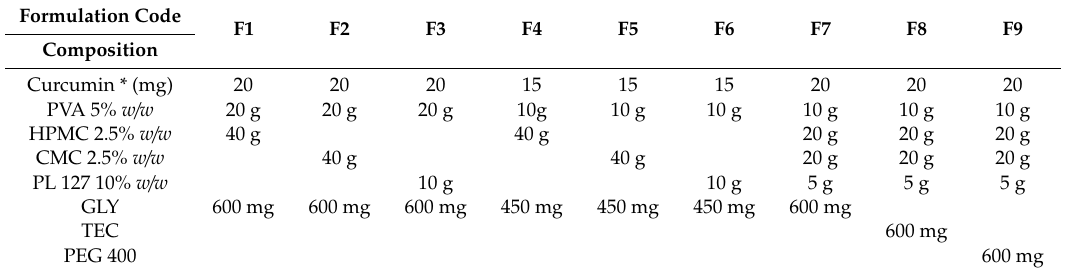
Table 1. Composition and formulation codes of the prepared ocular